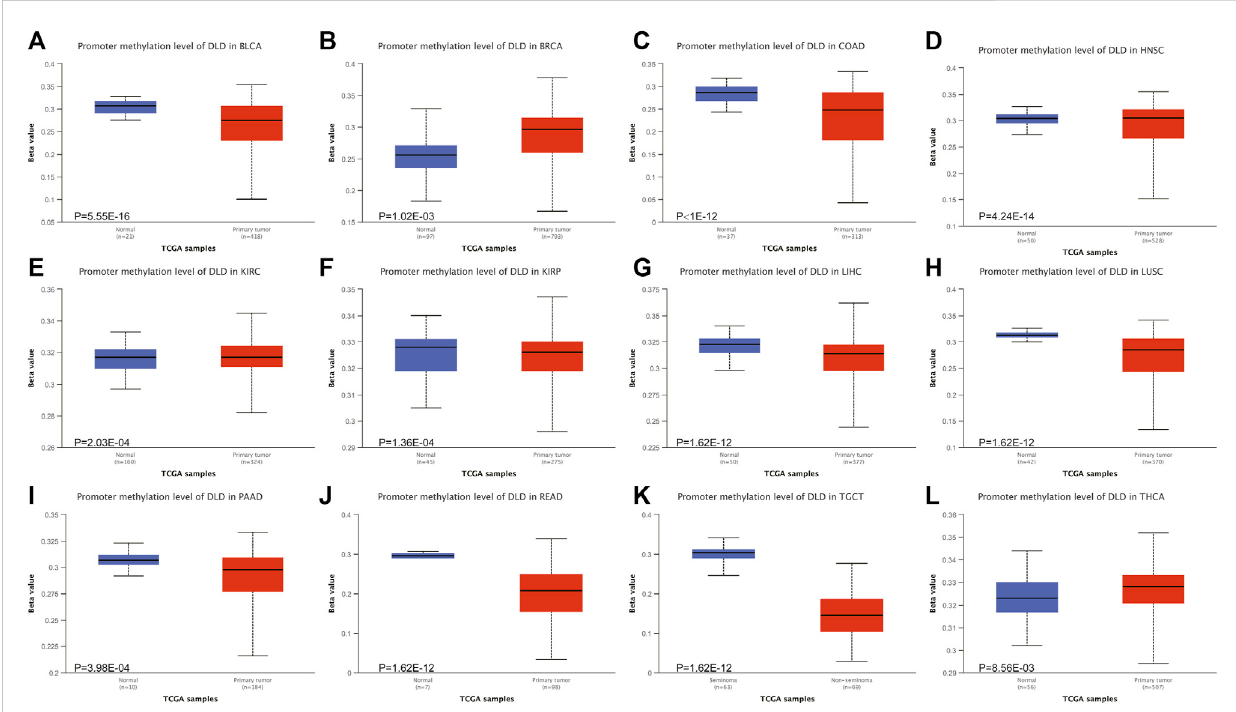
FIGURE 7 The DNA methylation levels of DLD in tumors. (A – L) The UALCAN database was used to compare the methylation of DLD between primary tumor samples and normal